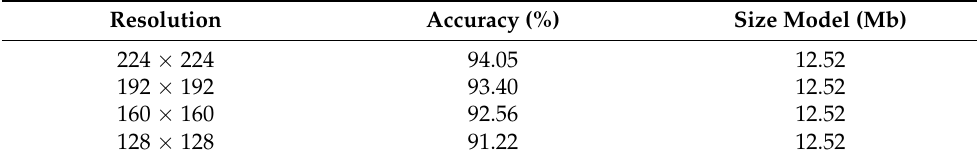
Table 3. Performance of MobileNets on different resolution multipliers (fixed width = 1.0).